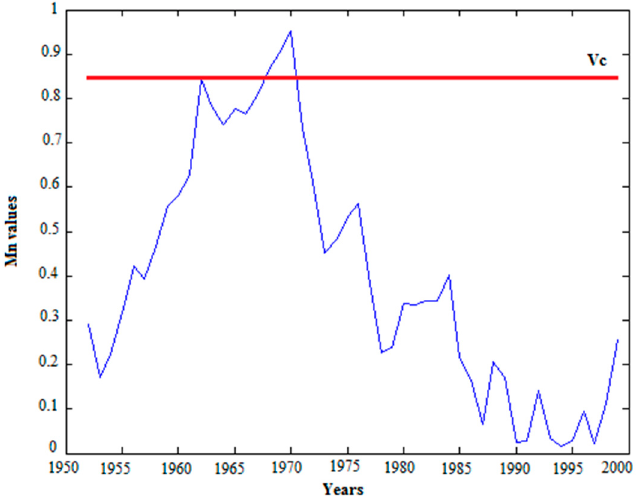
Figure 4. Temporal variability of M n values derived for the link between PDO and TSN at the Bagotville station (1950–2000).